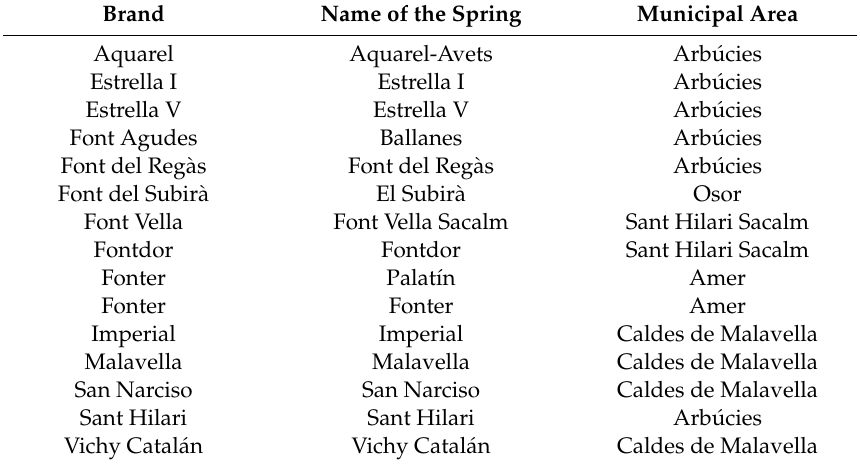
Table 5. Bottling plants for mineral water in the region of La Selva (Girona). Source: European Commission, List of Mineral Waters Recognized by Member States (consultation on 8 February